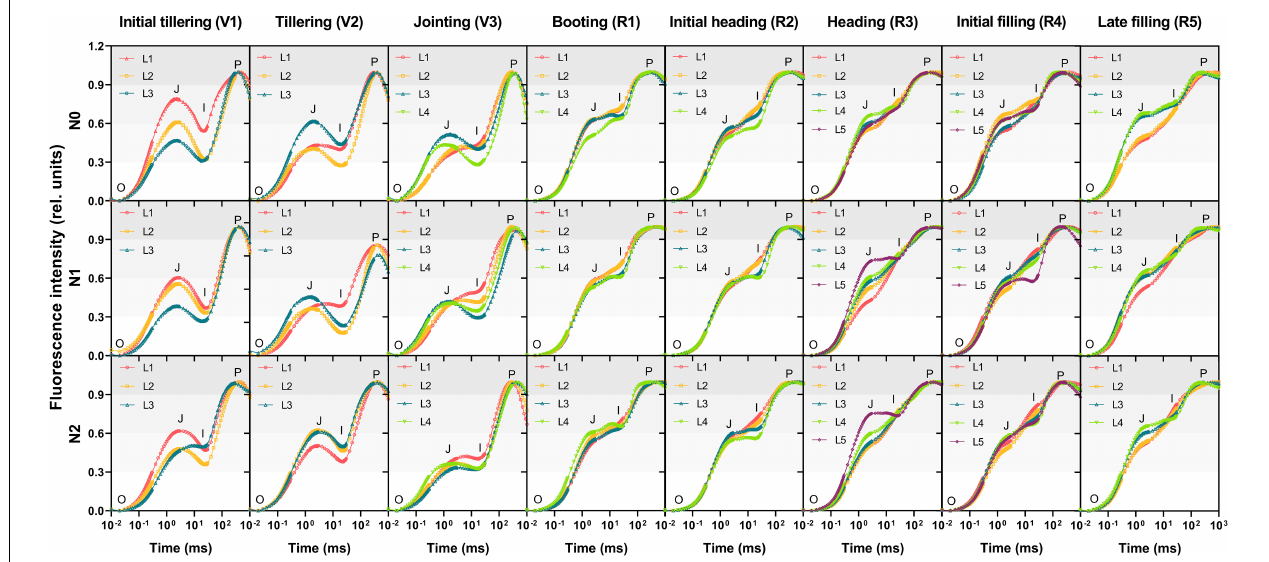
FIGURE 3 | The OJIP transients in leaves along the vertical distribution of the canopy during different growth stages. Curves are presented in the logarithmic time scale with the normalization by F 0 and F P to the P-level for eliminating the difference in light intensity. O (origin, all RCs open) is the minimum fluorescence level, P (peak, all RCs closed) is the maximum level, and J ( ∼ 2 ms) and I ( ∼ 30 ms) are intermediate inflections. Individual data points are the mean value of four biological replicates. L1–L5 represent the leaf position from bottom to top of the